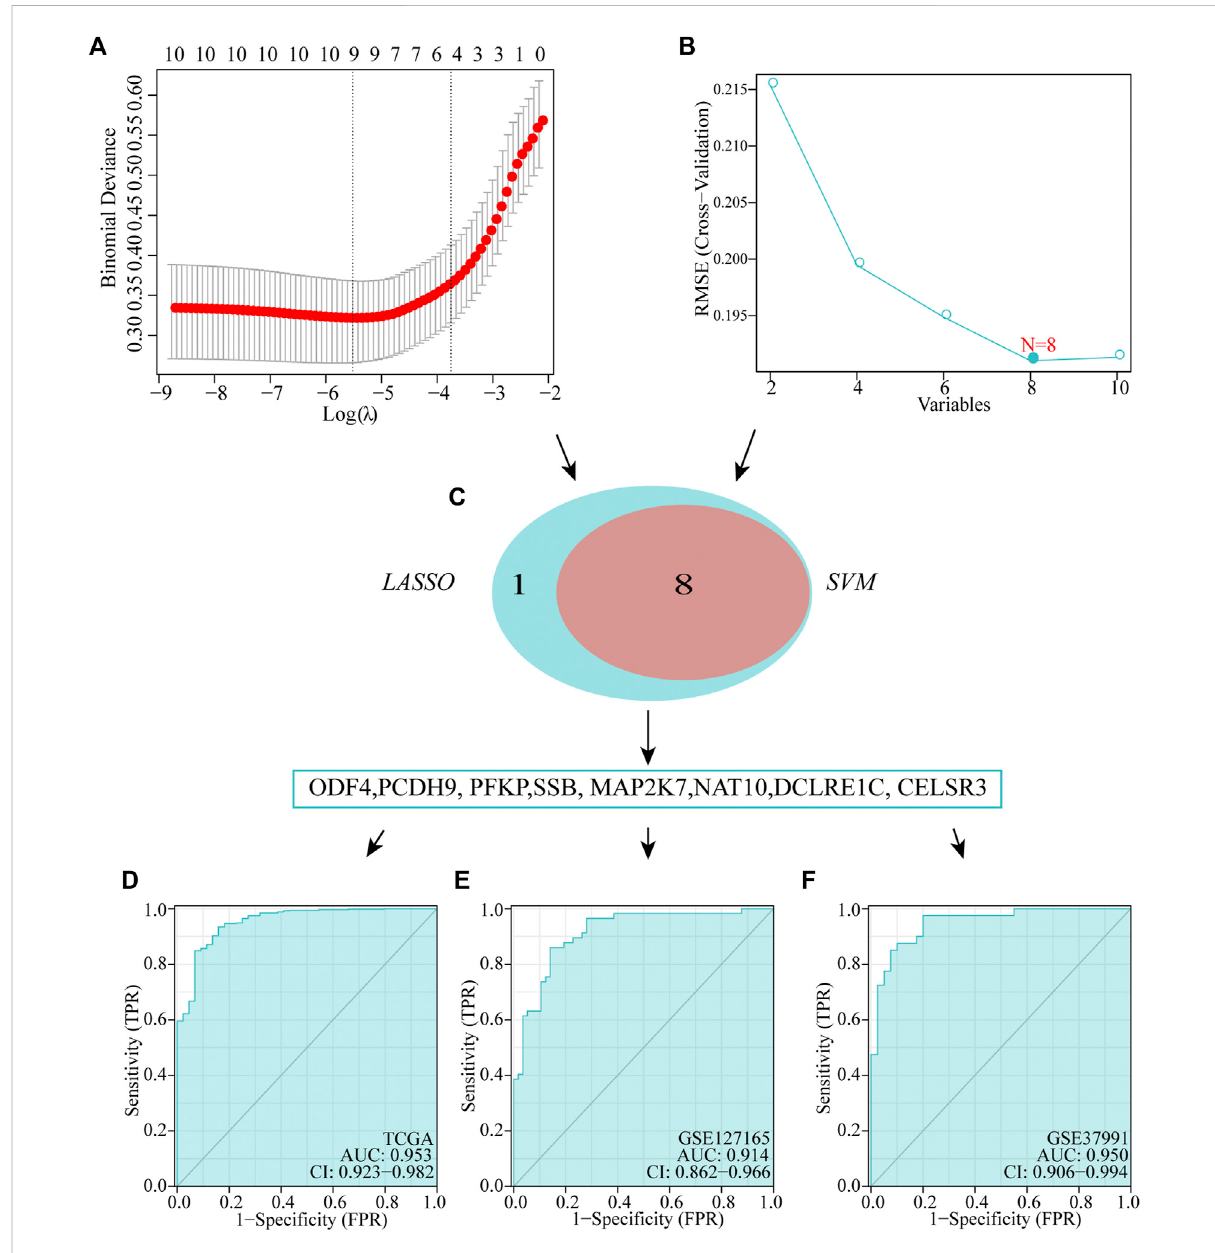
FIGURE 6 Establishment of multigene diagnostic signature. A totalof eight genes have been selected through LASSO (A) and SVM (B) analyses, with AUCs of 0.953 (D) : TCGA, 0.978 (E) : GSE127165, and 0.950 (F) :